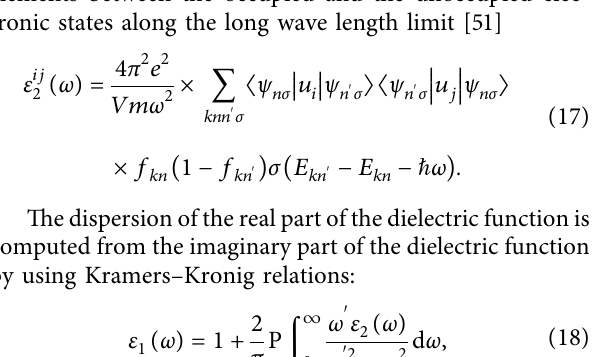
with respect to DFPT (a) and DFPT+ U 3